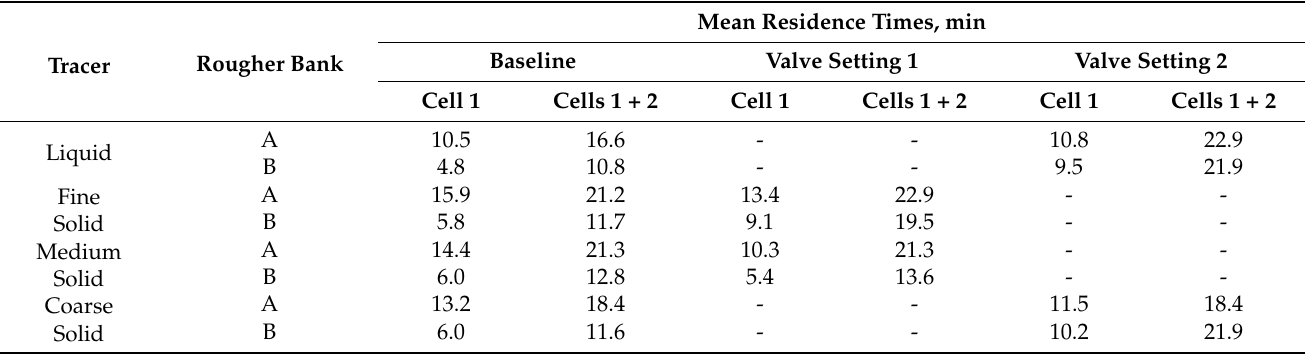
Table 2. Mean residence times for each valve setting and experimental